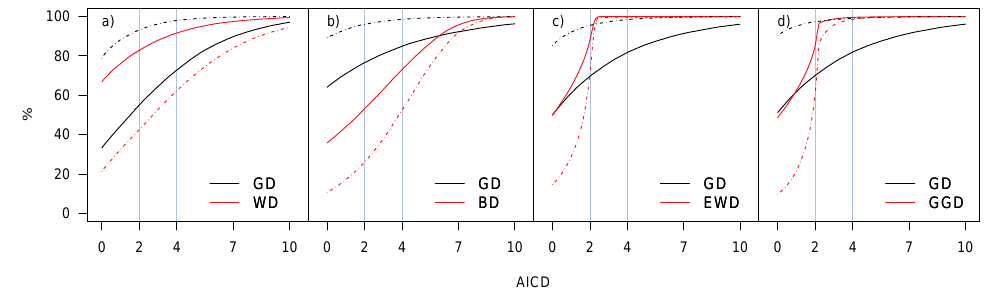
Fig. 6. AICD frequencies (CRU data set): percentages of all grid points and months a distribution yields AICD smaller or equal than a given value for the European region. The GD (black lines) is compared to (a) WD, (b) BD, (c) EWD and (d) GGD (red lines). Dashed-dotted lines with corresponding colours show the respective outcome for a simulated data set, representing gamma-distributed precipitation in Europe.